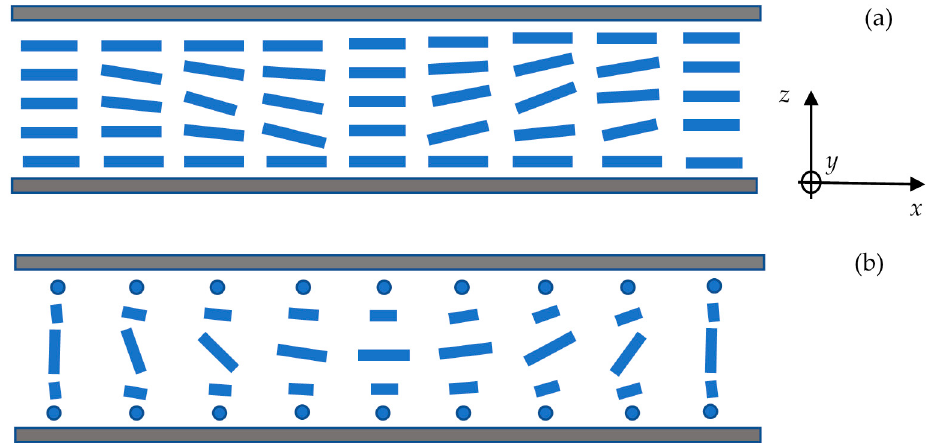
Figure 1. Schematic illustration of the LC director distribution for different domains: Williams domains ( a ); flexoelectric domains ( b ). For the Williams domains, the initial alignment is along the x -axis, while for the flexoelectric domains the alignment is along the y -axis.